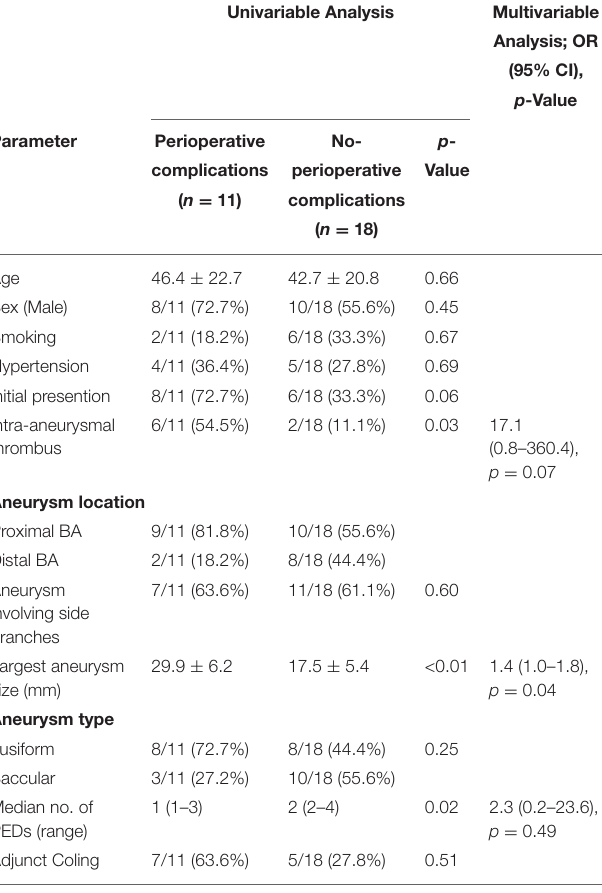
TABLE 3 | Univariate and multivariate analyses of factors associated with unfavorable clinical outcome. Univariable Analysis